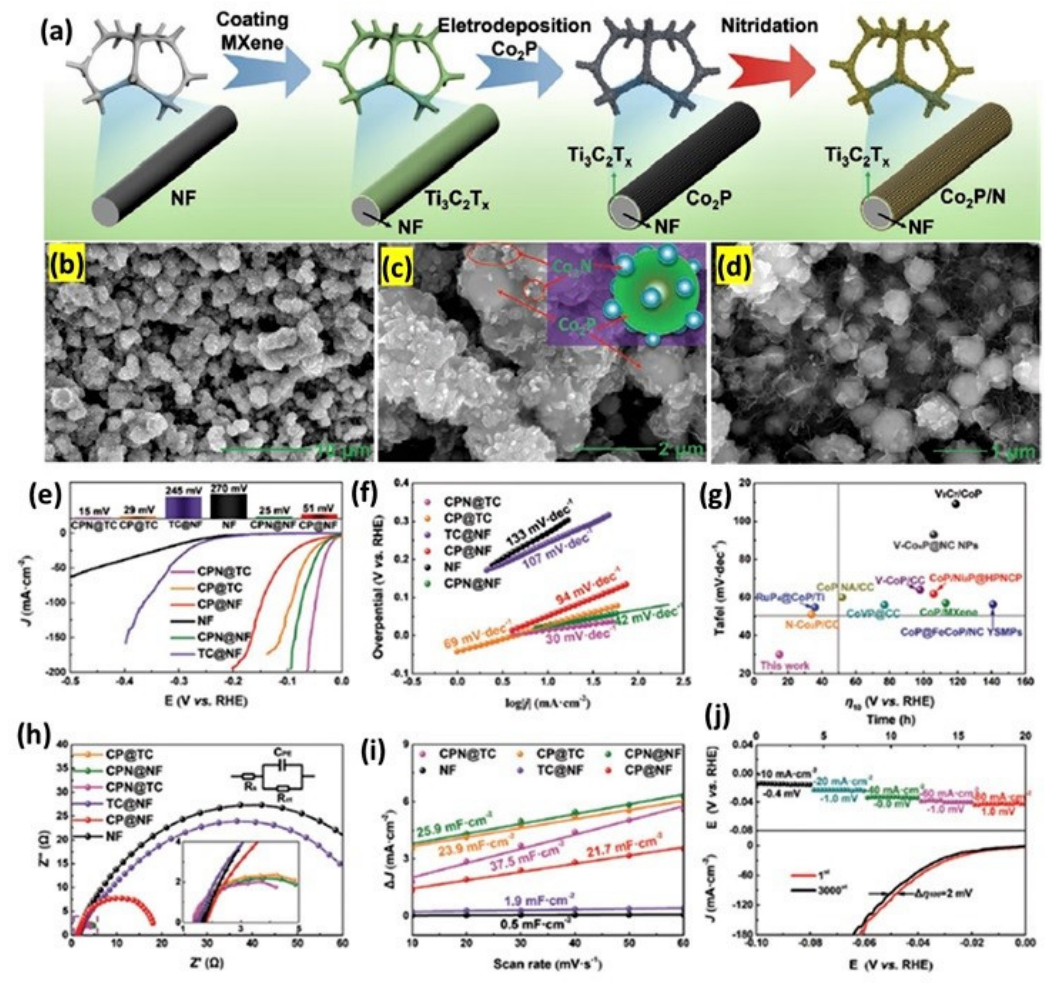
Figure 9. ( a ) Schematic illustration of the catalyst synthesis strategy. ( b – d ) SEM images of CPN@TC. ( e ) Polarization curves and ( f ) corresponding Tafel slopes of CPN@TC, CP@TC, CP@NF,